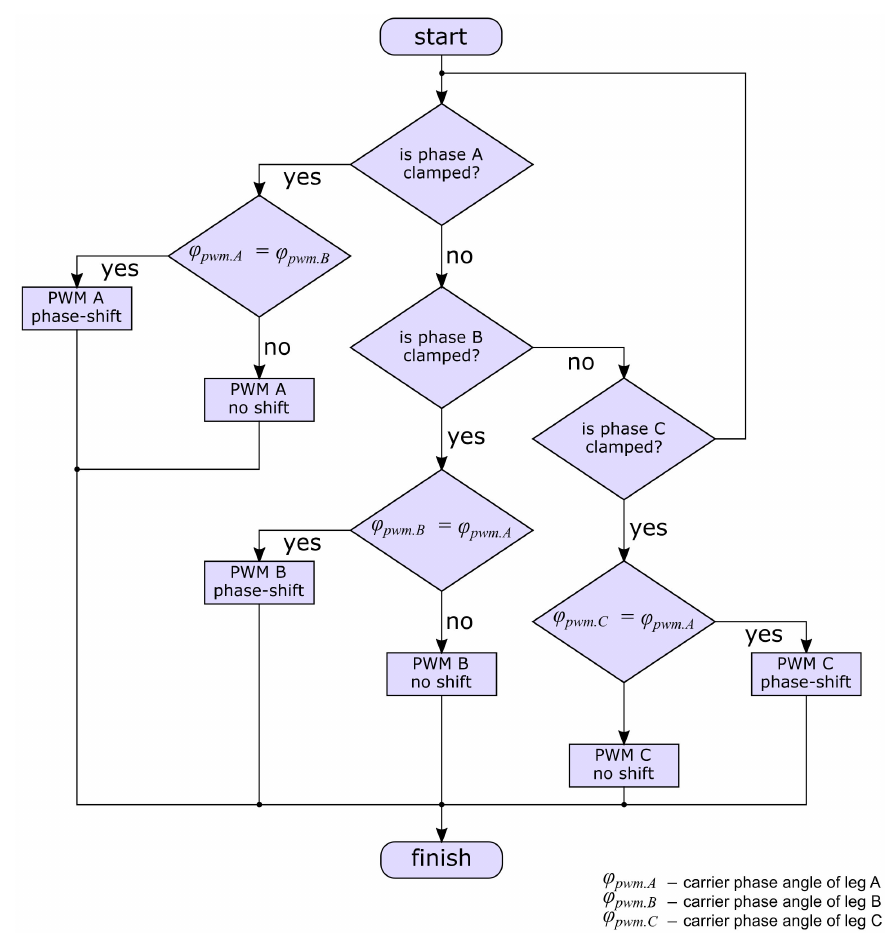
Figure 4. Flowchart of the proposed